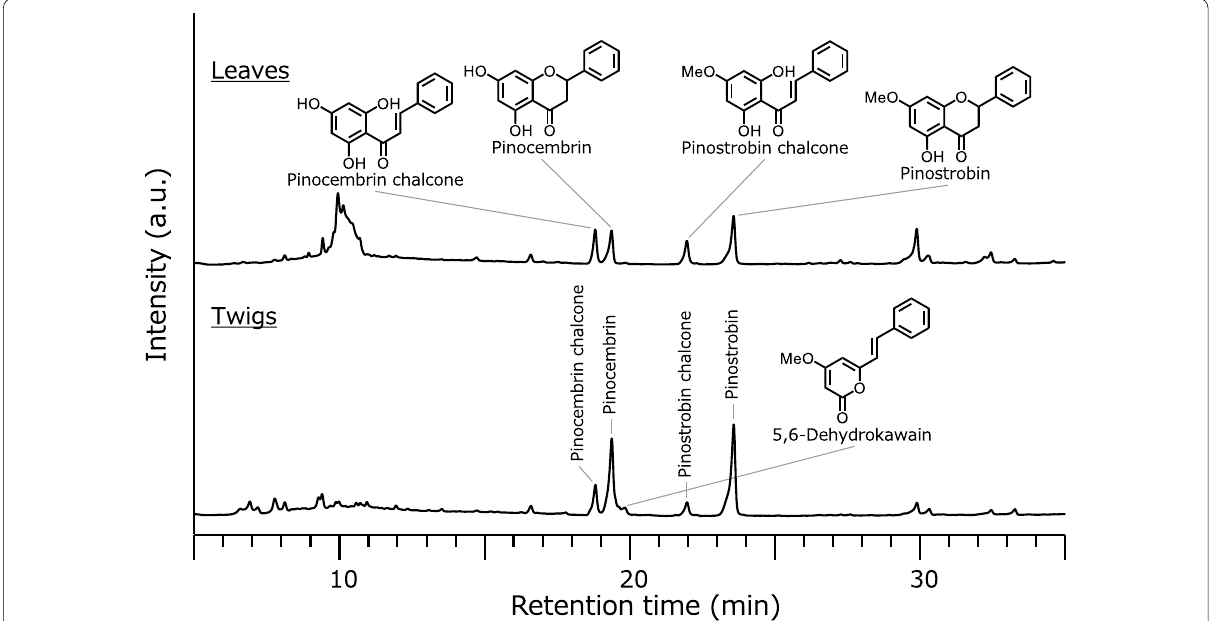
Fig. 7 Annotated example (B1, June) of an HPLC chromatogram from the 70% acetone extract